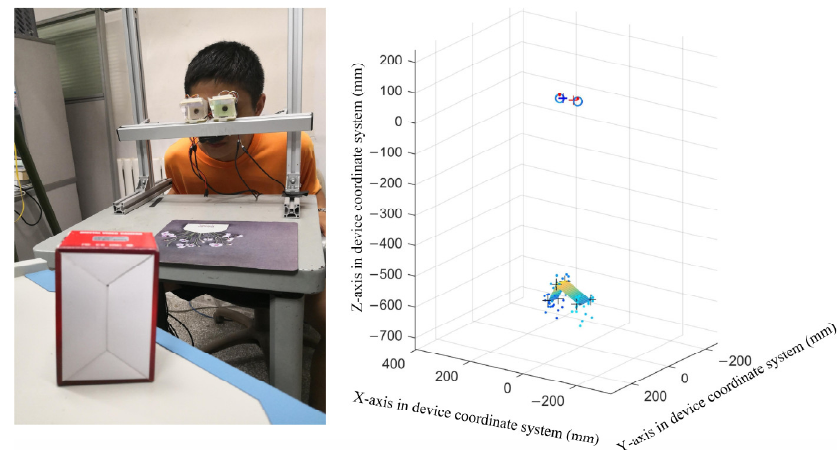
Figure 10. Appl. Sci. 2018 , 8 , x FOR PEER REVIEW